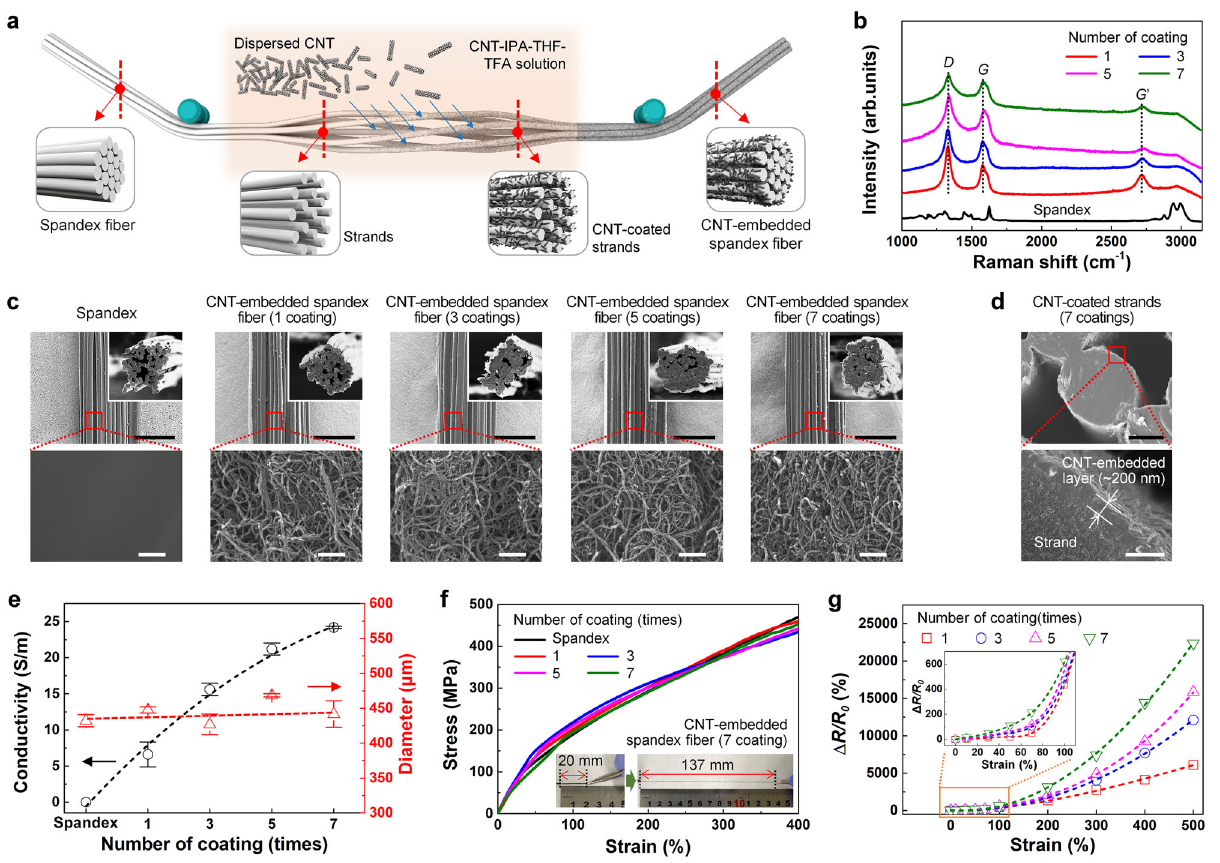
Fig. 2 Fabrication of CNT-embedded spandex fi ber and evaluation of its properties. a Fabrication process for the generation of CNT- embedded spandex fi bers. b Raman spectra of CNT-coated fi bers. c FE-SEM images of the fi bers after successive coatings. CNTs are embedded within the spandex fi ber comprising 56 strands. Scale bars: 300 μ m (top) and 300 nm (bottom). d FE-SEM image of a single strand from the interior of the coated spandex fi ber after 7 coatings. Scale bars: 30 μ m (top) and 500 nm (bottom). e Change in conductivity and diameter of spandex fi bers with successive coatings. f Stress – strain curve of the CNT-coated spandex fi ber after 1, 3, 5, and 7 coatings. g Change in resistance of the fabricated fi bers relative to the original value with